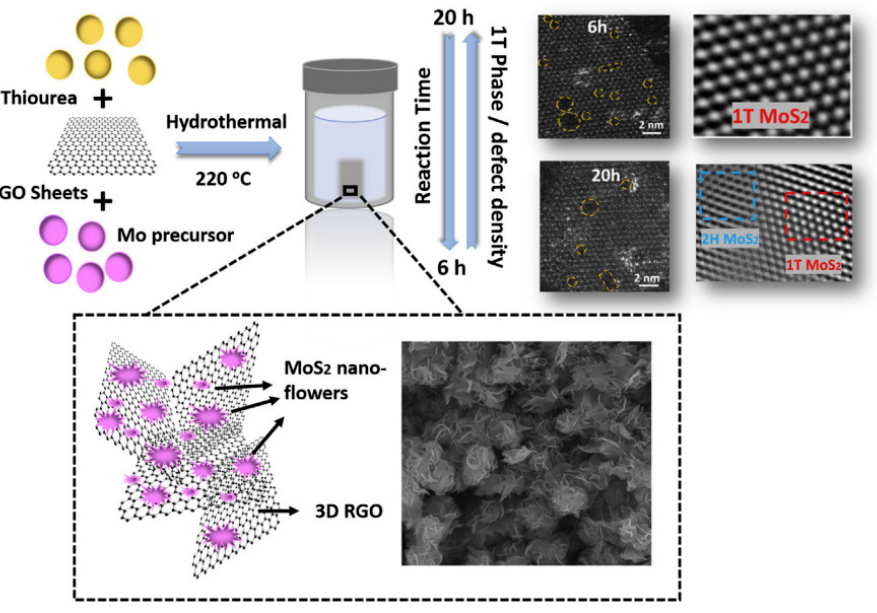
Figure 5. Scheme representing the formation of defective 1T MoS 2 nanoflowers on rGO substrate [37]. Reprinted with permission from [37]. Copyright 2019. Elsevier.